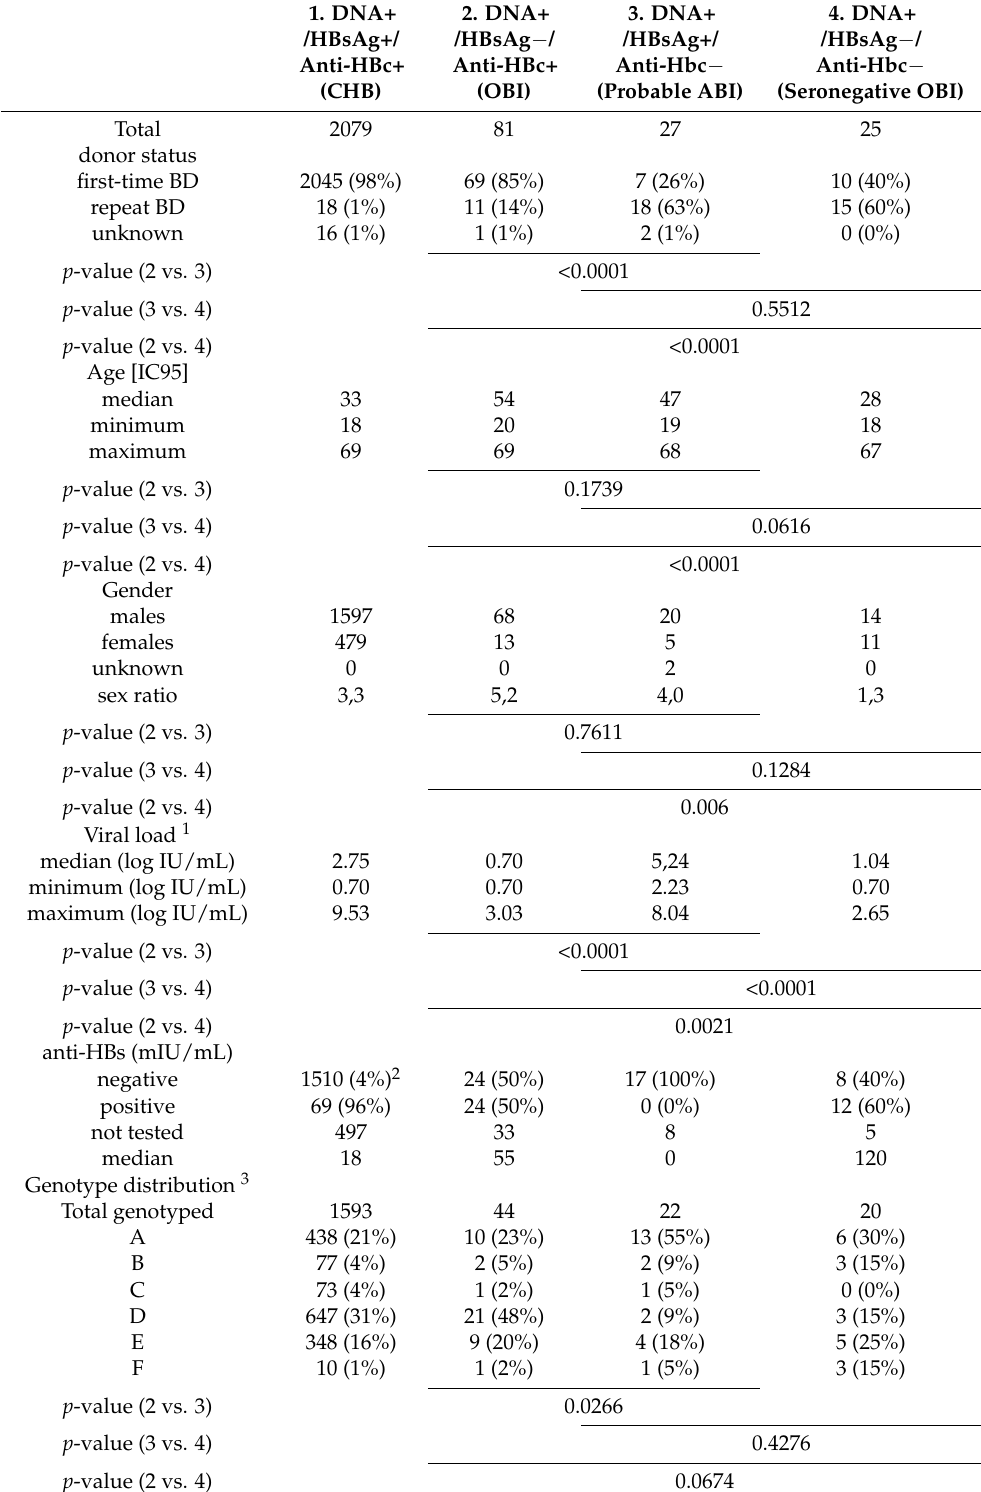
Table 1. Comparison of demographic and virological data in the four donor populations with positive HBV